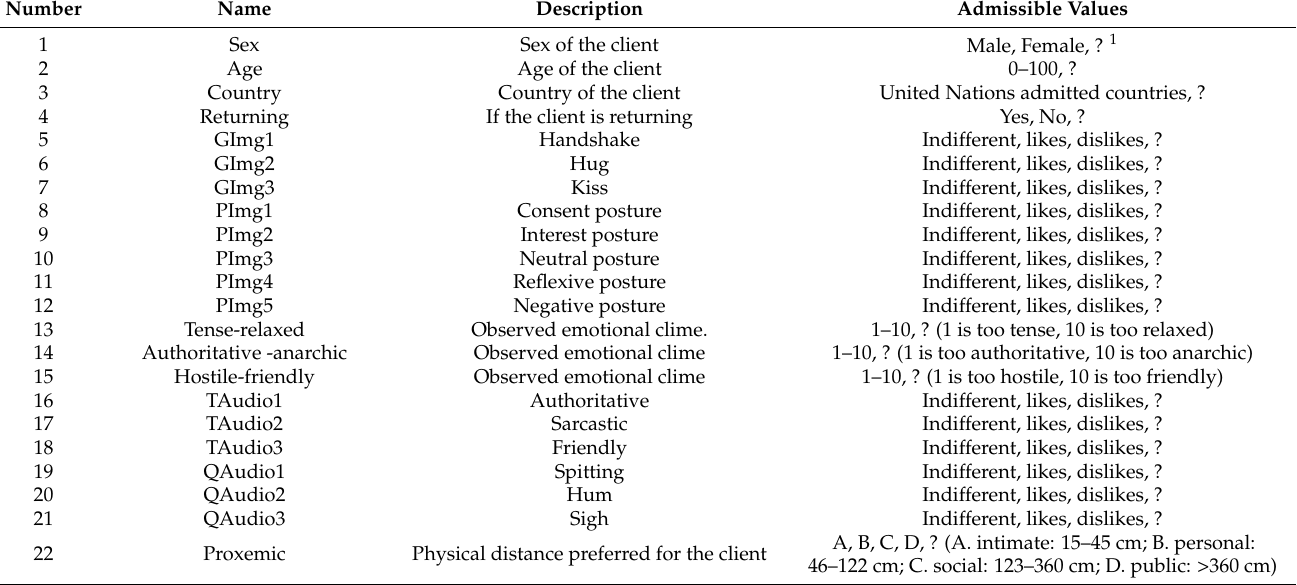
were used to characterize each client are shown in Table 1. Table 1. Variables from the questionnaire, used to assess the non-verbal preference of the clients.